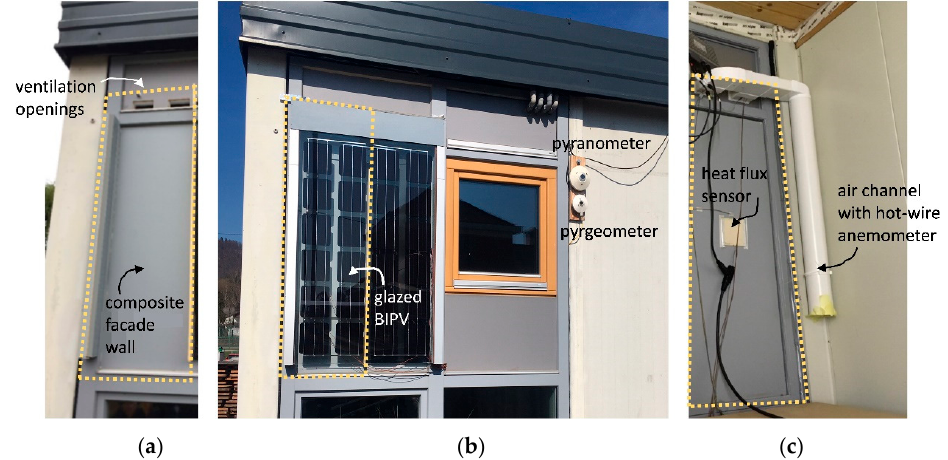
Figure 1. Experimental semitransparent building integrated photovoltaics (BIPV) glazed façade structure (shown by the rectangle section). ( a ) The façade wall with two ventilation openings, each of them was enclosed by a fan; ( b ) BIPV glazed structure installed 80 mm in front of the façade wall, and ( c ) interior of experimental BIPV façade structure—air channels were thermal insulated during the